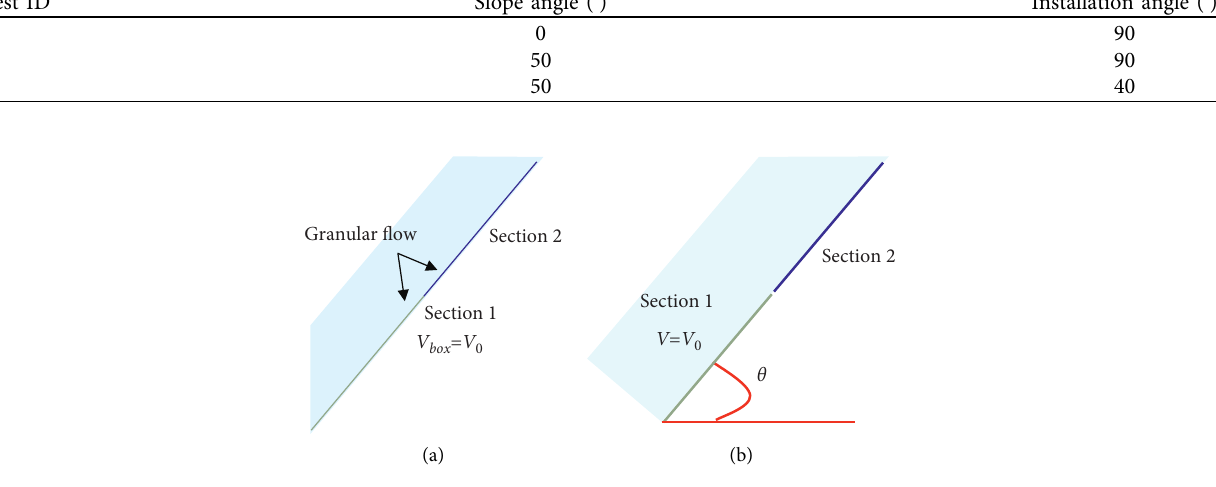
Figure 9: The geometry of the numerical experiments: (a) titled rigid wall and (b) vertical rigid